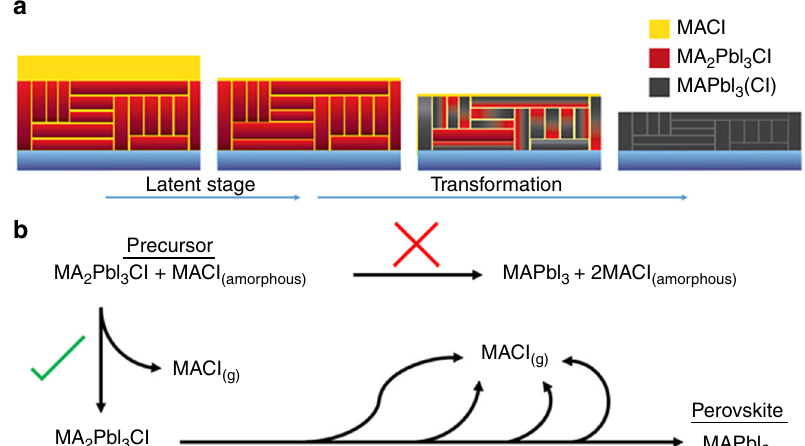
Fig. 5 Self-regulating model of the transformation from precursor to perovskite. a Model detailing the loss of disordered MACl in the latent stage, followed by the conversion of precursor to perovskite with continued loss of MACl regulating the transformation. b Chemical model of the transformation from precursor to perovskite. The reaction does not proceed initially in the presence of MACl. Once the existing MACl has evaporated, the transformation